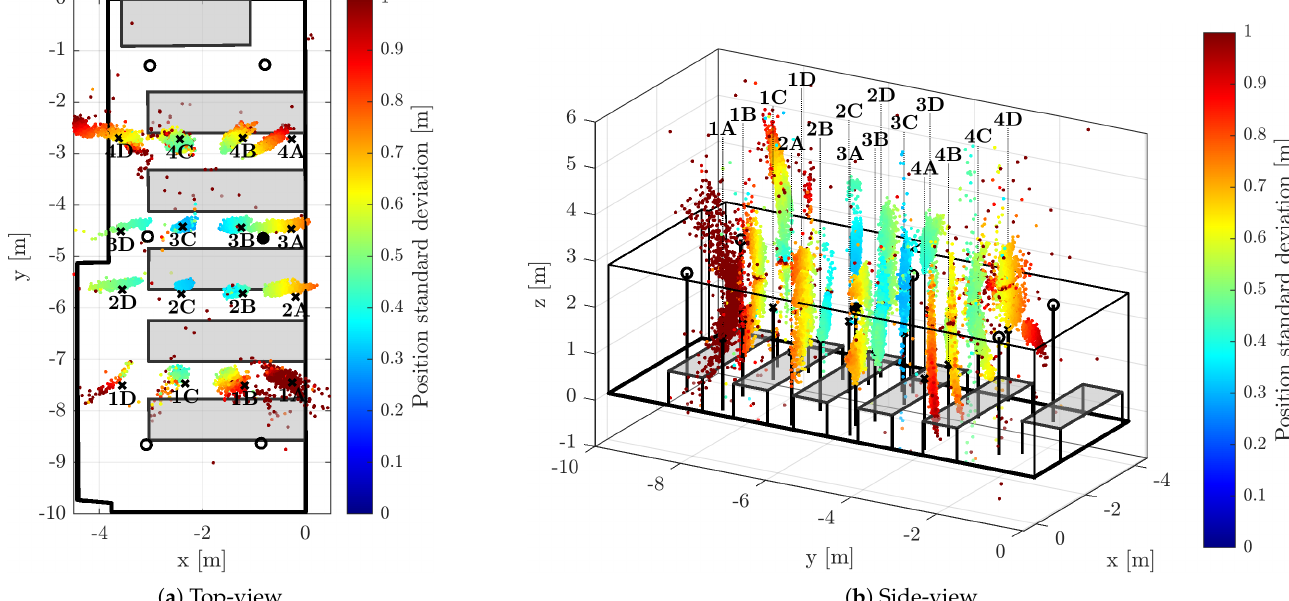
Figure 7. 3D Position estimates obtained with TDoA correction based on C int CFO ( ν CINT